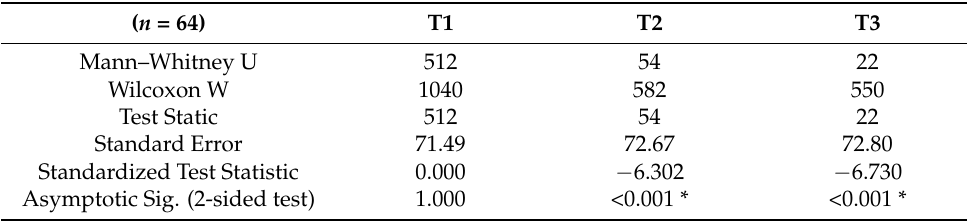
Table 2. PP in active vs. placebo group in T1, T2, and T3 (Mann–Whitney